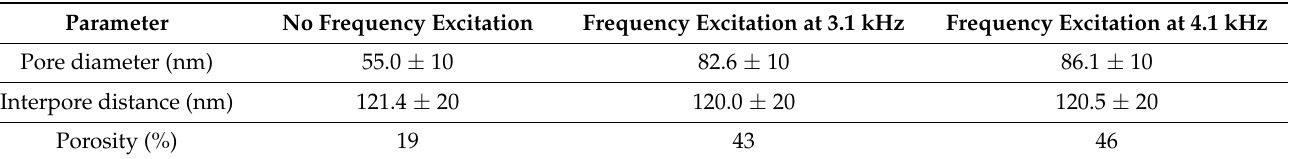
Table 3. Morphological parameters (D p , D c , and P) of the AAO nanoporous membrane obtained during the two-step anodization process.